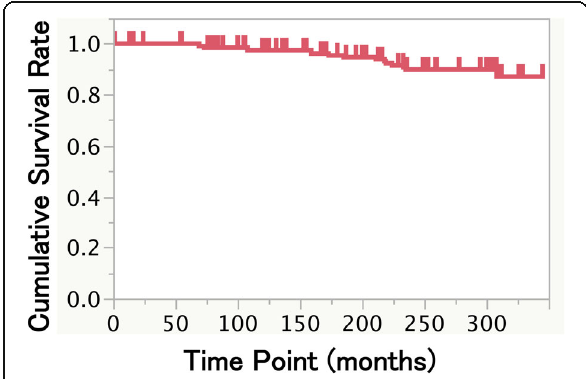
Fig. 1 Kaplan-Meier cumulative survival rate at 10, 15, and 25 years after the prosthesis setting